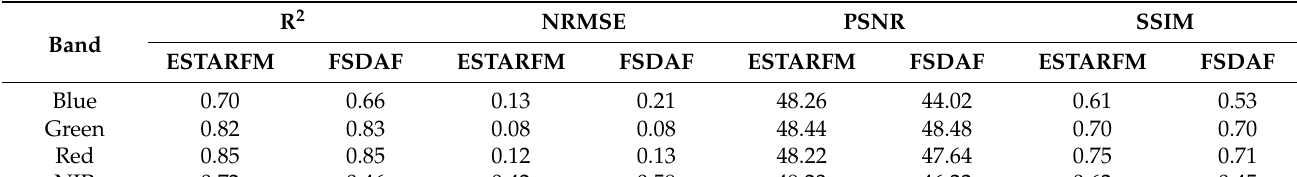
Figure 4. Comparison of the fusion images of ( a ) Landsat 8; ( b ) ESTARFM; and ( c ) FSDAF. Table 3. The evaluation of fusion image accuracy for the ESTARFM and FSDAF models.